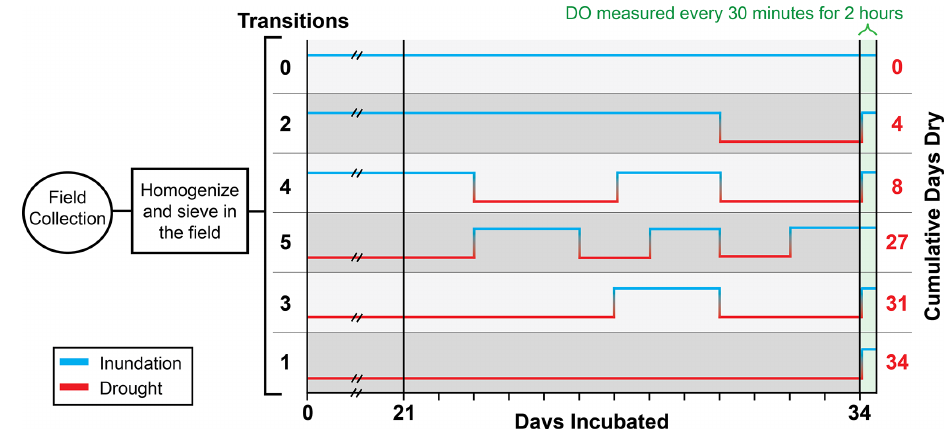
Figure 2. Experimental design of batch reactor incubations subjected to six treatment regimes of inundated (blue line) and dry (red line) conditions. Black values on the left indicate the number of inundated–dry transitions, including the final inundation that all treatments experienced immediately prior to the measurement of respiration. Red values on the right indicate the number of cumulative dry days (e.g., treatments with one or three transitions experienced 34 or 31 cumulative dry days, respectively. Transitions between inundated and dry conditions started on day 24. All treatments were held at either an inundated or dry state prior to day 24. Treatments are ordered by the number of days